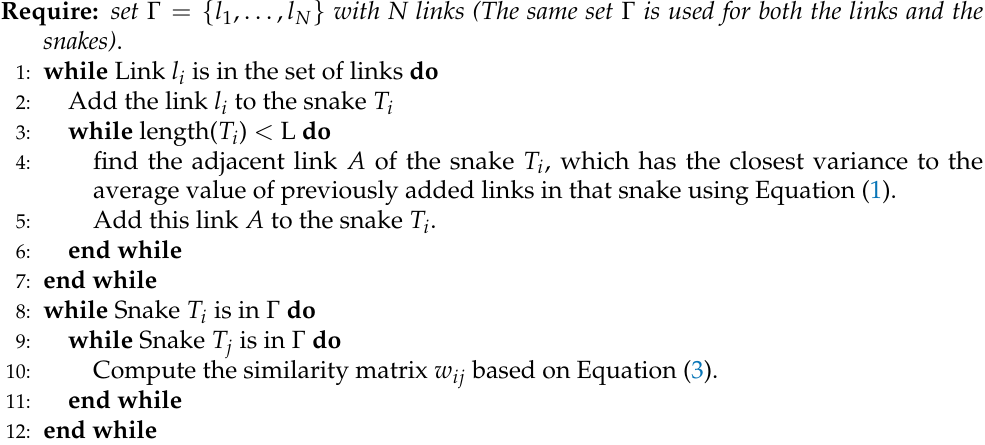
Algorithm 1 Snake Similarity Matrix Algorithm for the Transportation